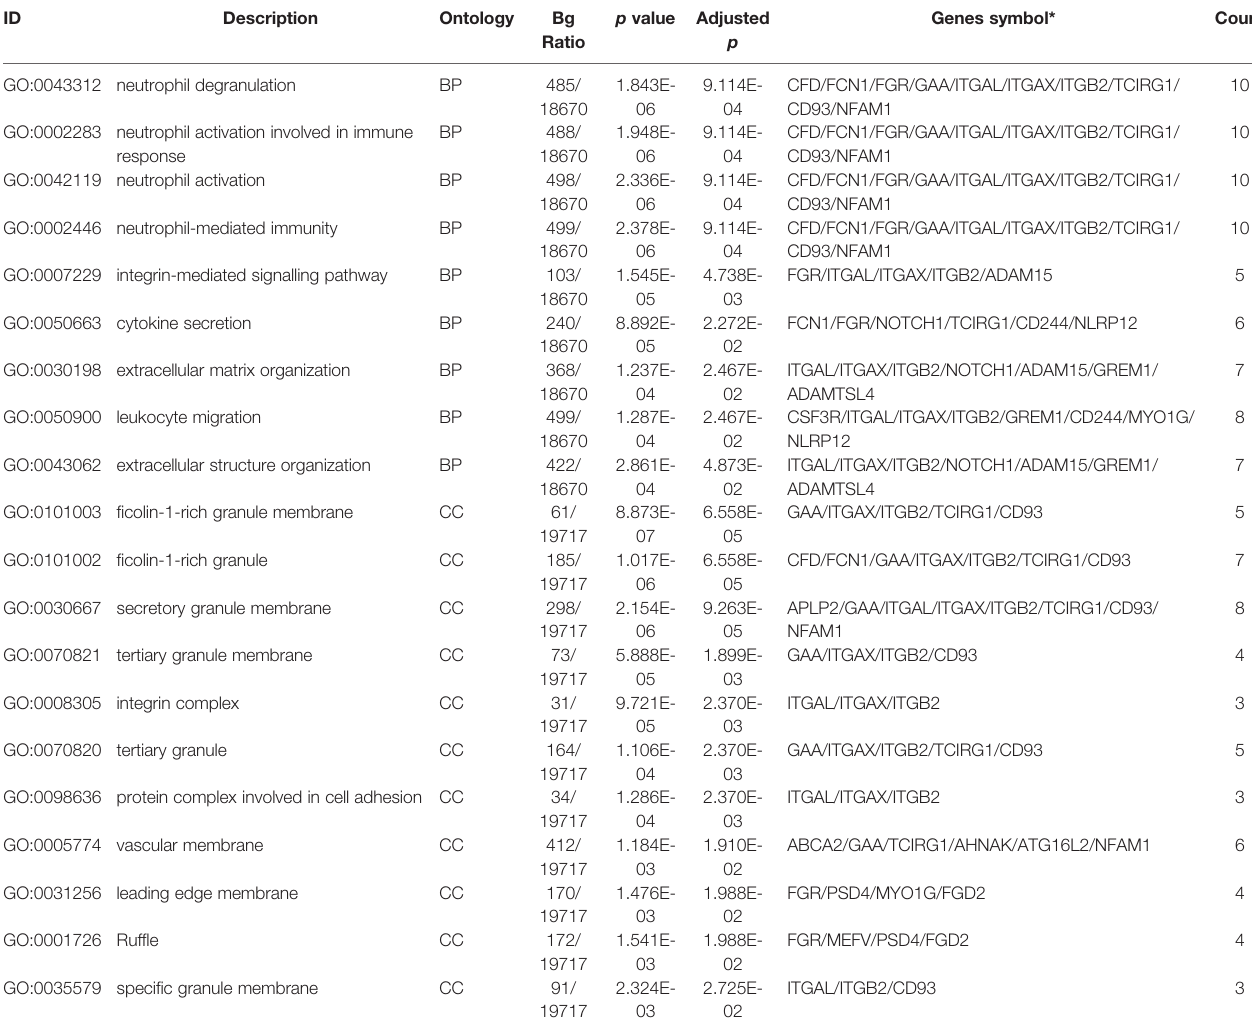
TABLE 3 | Functional enrichment analysis of mRNAs in the ceRNA network in